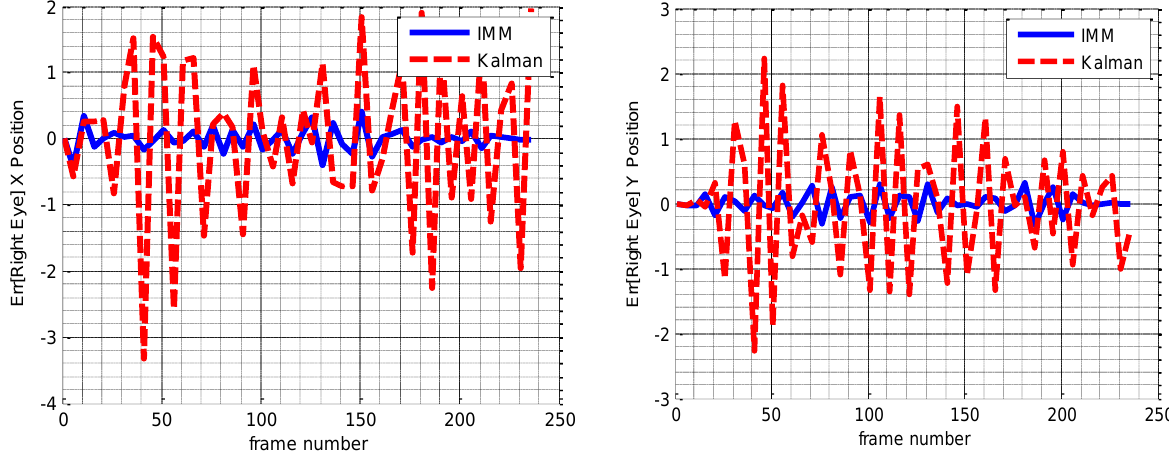
Figure 14. The error of right eye estimation of position